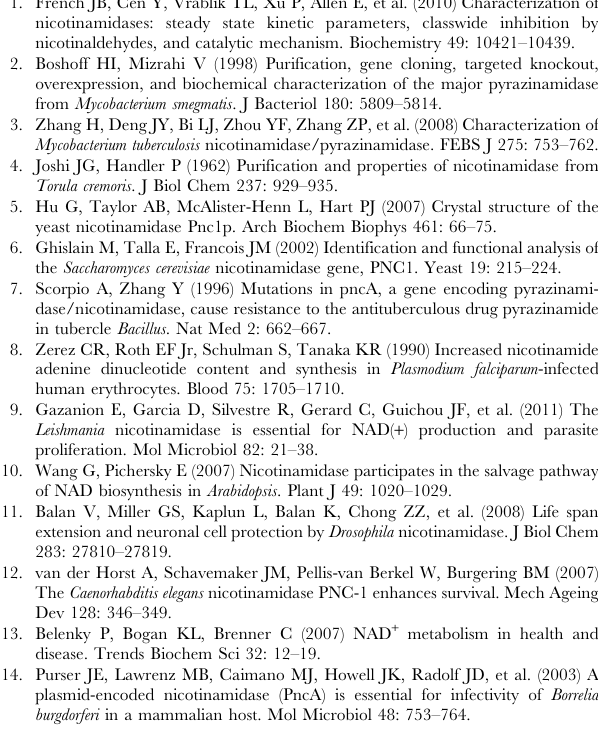
Figure S7 Phylogenetic distribution of characterized